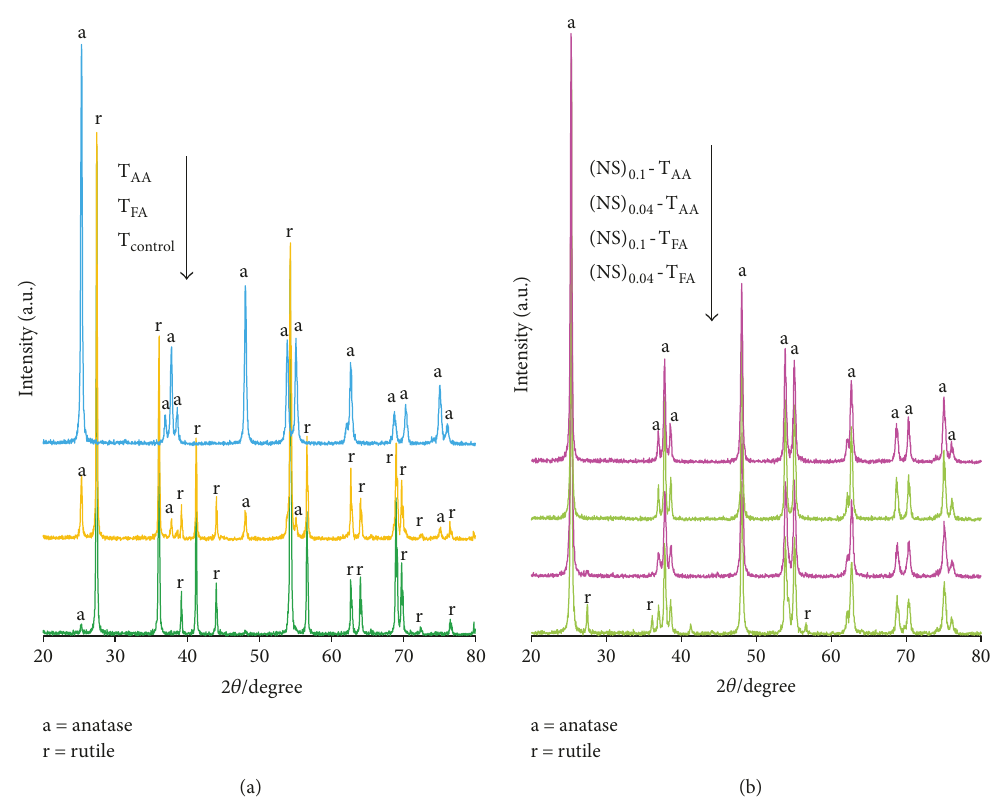
, T , and T and (b) (NS) -T , (NS) -T , (NS) -T , and (NS) -T powders control FA AA 0.04 FA 0.1 FA 0.04 AA 0.1 AA -T and (NS) -T (where x = 0 , 0.02, 0.04, 0.06, 0.08, and 0.1) TiO powders x FA x AA 2